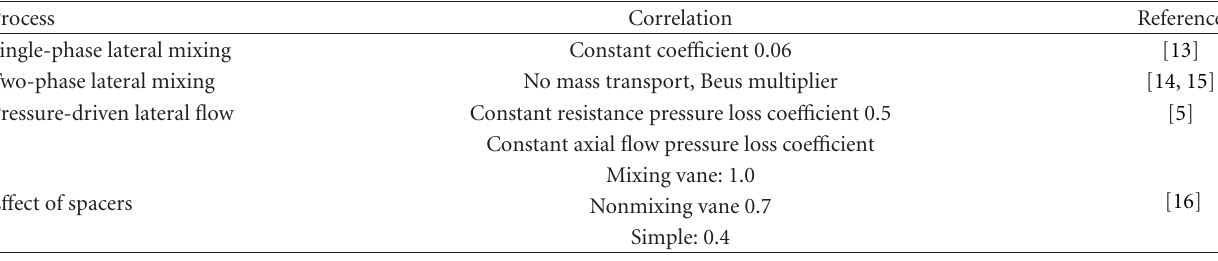
Table 7: Empirical correlations used for the bundle tests.